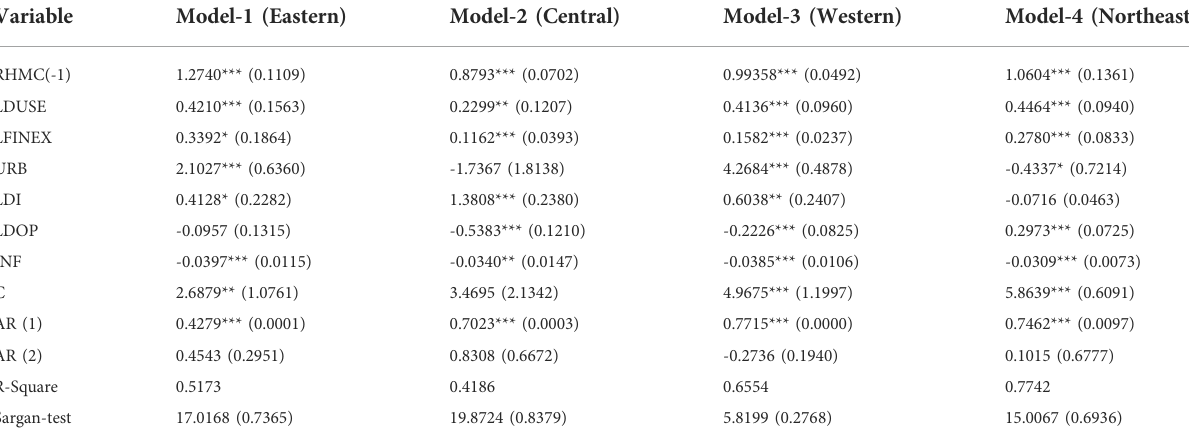
TABLE 11 Results of systematic GMM estimation of the impact of digitization on rural human capital accumulation in different regions.